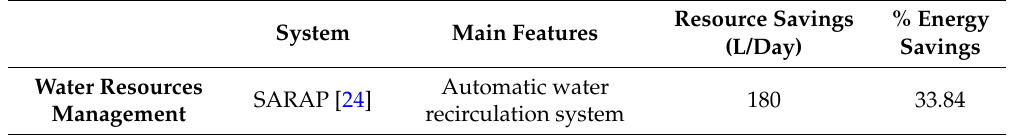
Table 14. Water resources energy study results.